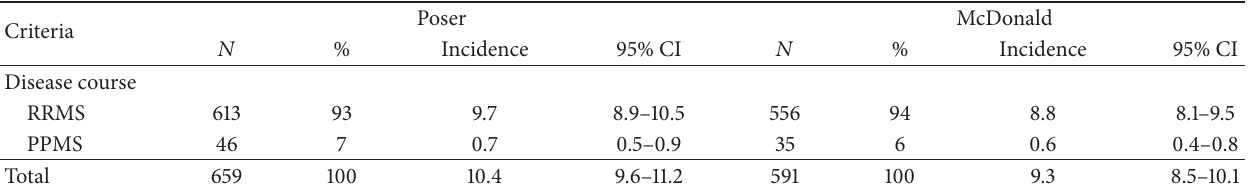
Table4:RRMSandPPMSincidences(I)andtotalincidenceper10 5 person-yearswith95%confidenceintervals(CIs)byPoserandMcDonald criteria in the whole study cohort from 2001 to